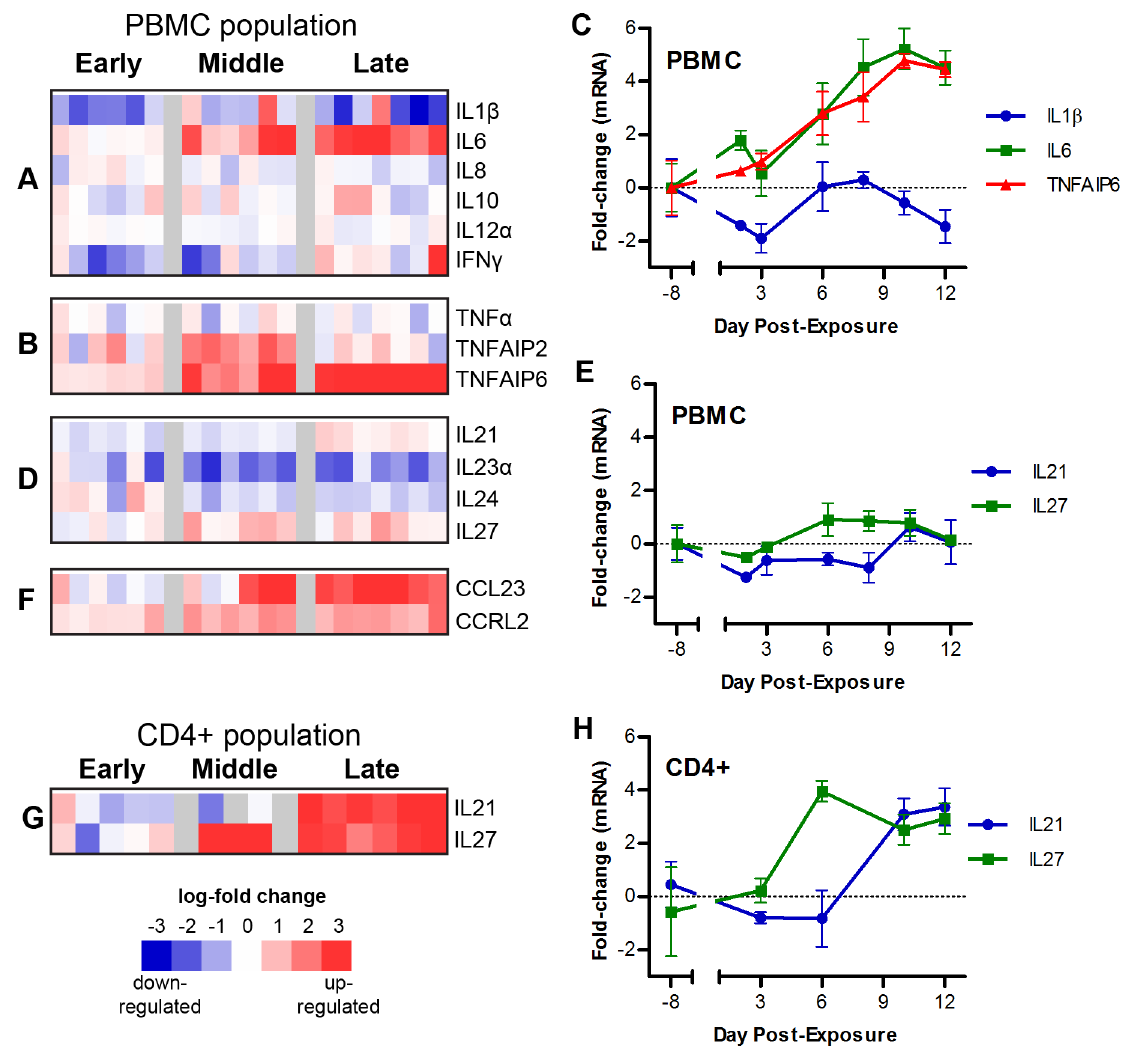
Figure 4. Cytokine mRNA expression following LASV challenge. Heatmaps show the gene expression levels of (A) previously analyzed cytokines in LASV disease: IL1 b , IL6, IL8, IL10, IL12 a , and IFN c ; (B) TNF a and TNF-responsive genes; (D) cytokines IL21, IL23 a , IL24, and IL27; and (F) chemokines CCL23 and CCRL2 from the whole PBMC population; as well as (G) IL21 and IL27 from the CD4 + population (isolated from PBMCs). Line graphs show the expression levels (mRNA log2 fold change over time) of (C) IL1 b , IL6, and TNFAIP6; and (E) IL21 and IL27 from the whole PBMC population; and (H) IL21 and IL27 in the CD4 + population.